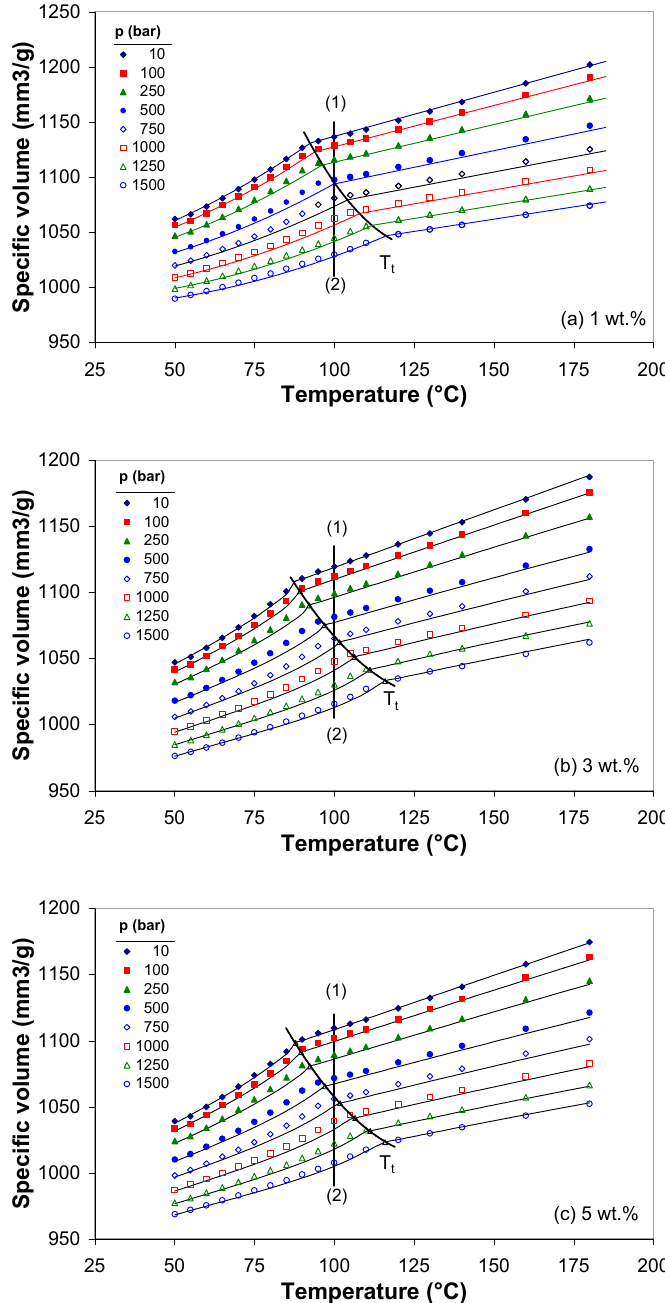
Figure 7. Specific volume as a function of temperature and pressure for EVA / MWCNT composite with ( a ) 1 wt.%, ( b ) 3 wt.% and ( c ) 5 wt.% MWCNTs (The solid line represents the Tait model).